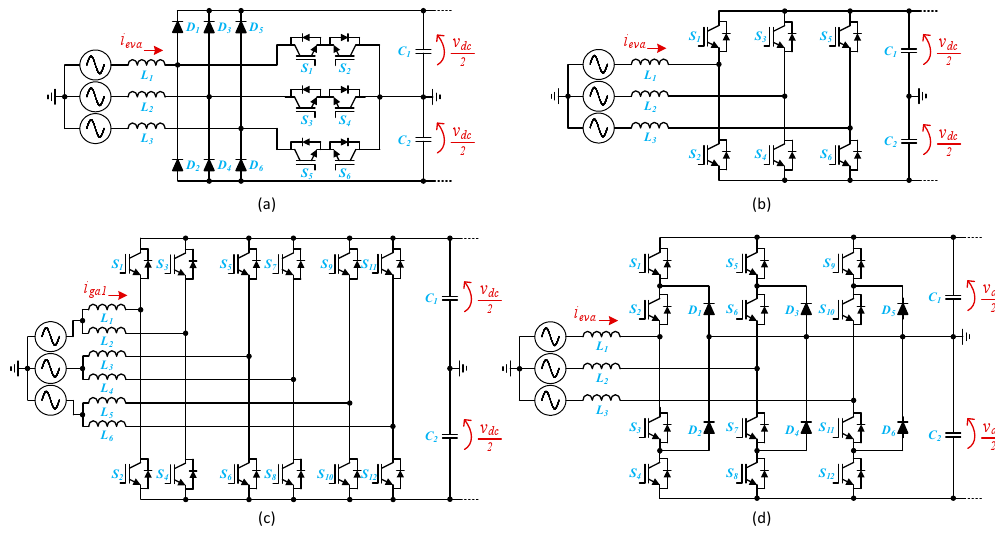
Figure 6. Main three-phase power electronics converters used as front-end power stage of off-board EVBC: ( a ) unidirectional VIENNA-type topology; ( b ) bidirectional full-bridge; ( c ) bidirectional interleaved full-bridge; ( d ) bidirectional multilevel.